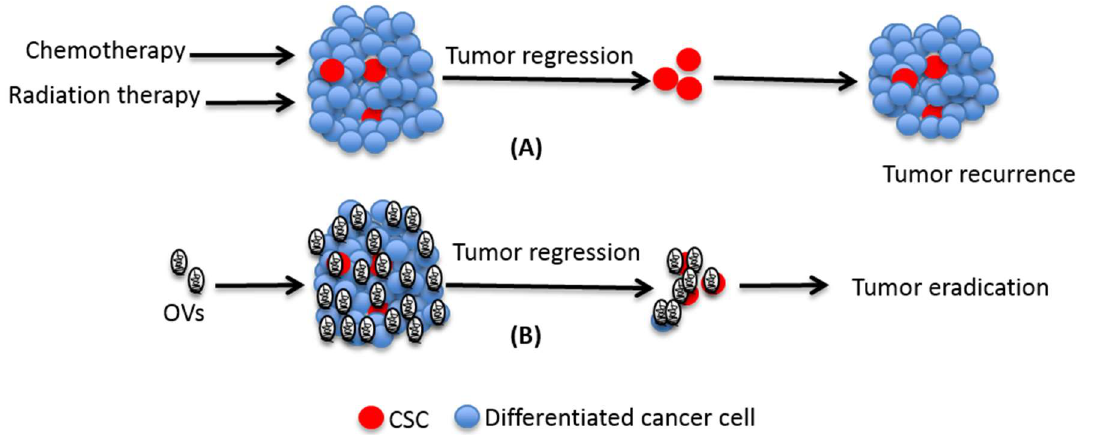
Figure 1. Role of cancer stem cell (CSCs) in traditional treatment failure. While chemo- and radiation-therapy can efficiently kill differentiated cells that make the bulk of tumor, they often fail to kill CSCs. Due to their ability to undergo self-renewal and differentiation, the surviving CSCs can cause disease relapse after initial remission. Unlike the conventional therapies, OVs have the potential to kill both differentiated cells as well as CSCs and hence they may cause eradication of the disease.